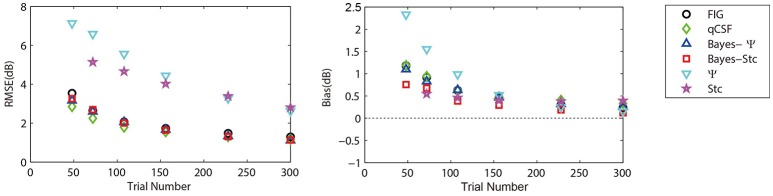
Average precision (left) and relative bias (right) estimates of the methods used in simulation of an amblyopic subject. Different methods are represented by different colors and symbols (see legend).